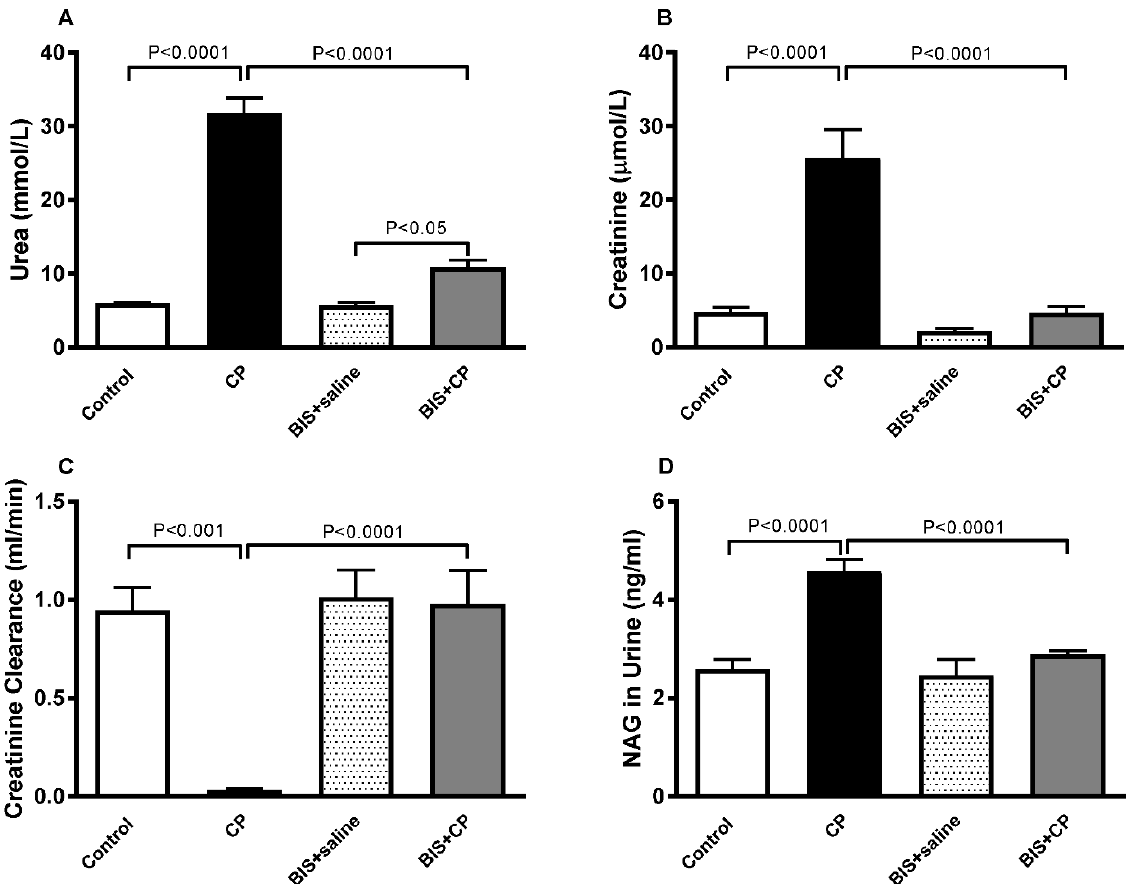
Figure 3. The plasma levels of urea ( A ) and creatinine ( B ), and creatinine clearance ( C ), as well as the level of urine NAG ( D ) in mice treated orally with either sunflower oil (control) or bisabolol (BIS, 25 mg/kg) with or without cisplatin (CP, 20 mg/kg) given intraperitoneally (n = 6). Mean ± SEM. Statistical analysis by ANOVA 1 followed by Holm–Sidak’s test.